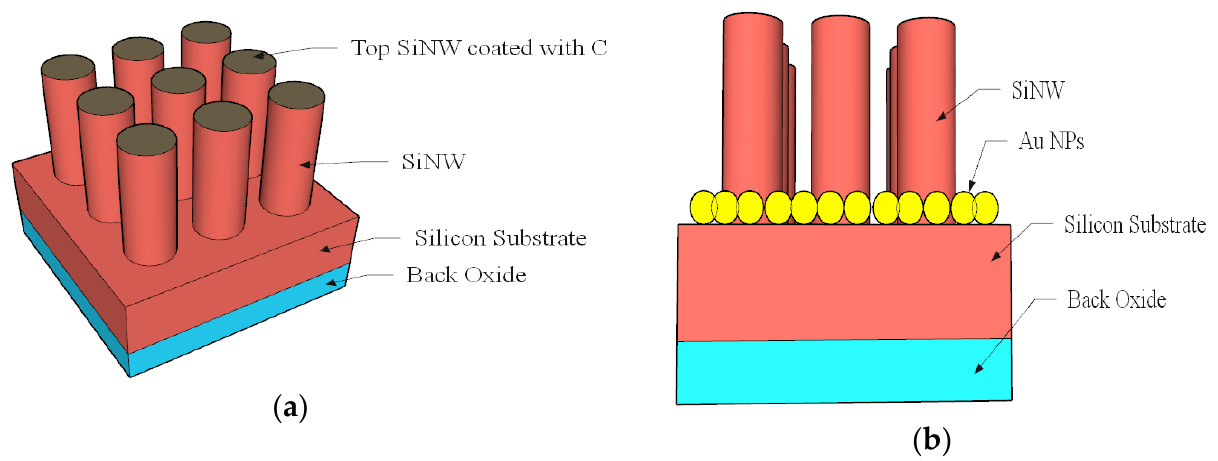
Figure 4. ( a ) Graphene layer coats the top SiNWs surface; ( b ) Au NPs distributed on the top of the silicon substrate.